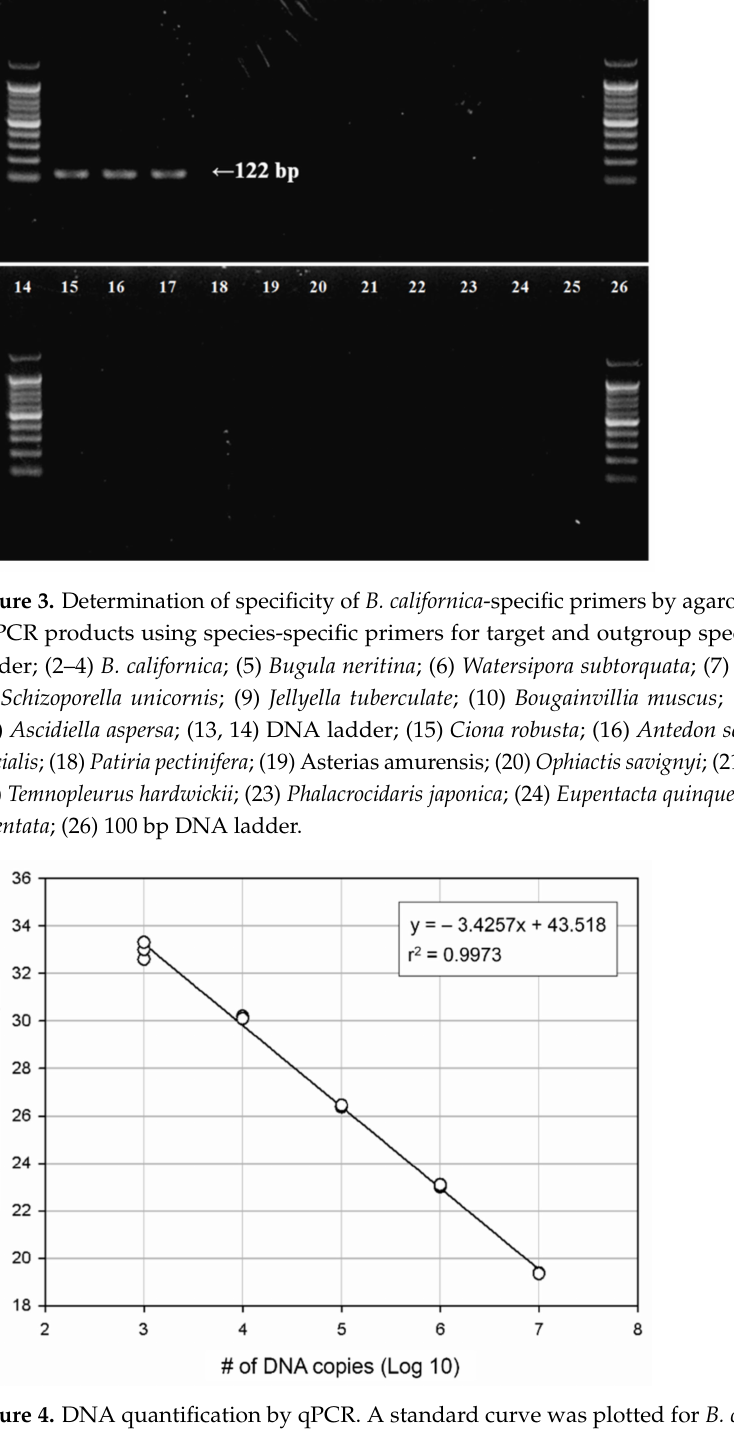
Figure 4. DNA quantification by qPCR. A standard curve was plotted for B. californica . Each point represents the C t value measured for the fluorescence signal generated from serial dilutions of B. californica DNA. The slope is −